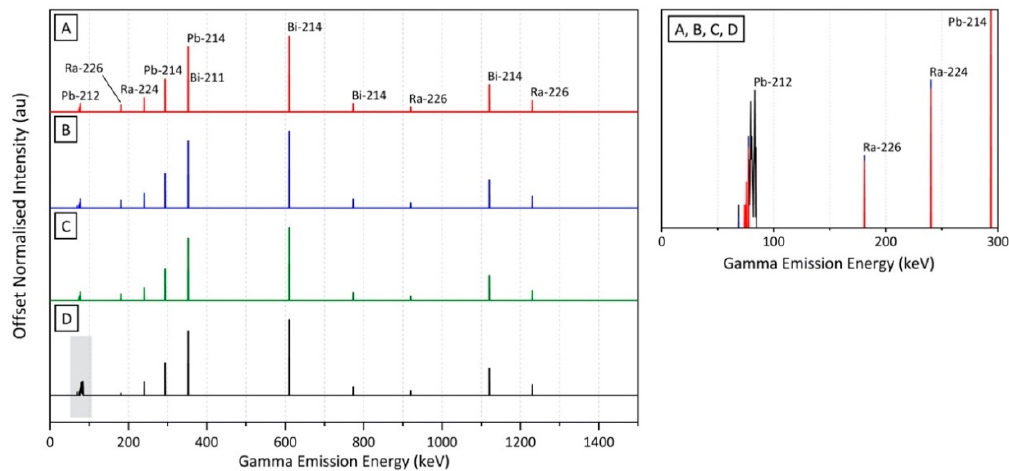
Figure 4. Gamma-ray spectra (A, B, C and D) from the four regions identified within Figure 2, corresponding the three areas of elevated activity (A, B, C) alongside a portion of the mine site (D) to the south, where background (non-elevated) count rates were measured. Inset; low-energy region (0–300 keV) of the gamma-ray spectra (regions A, B, C and D) illustrating the Pb and Ra peaks.